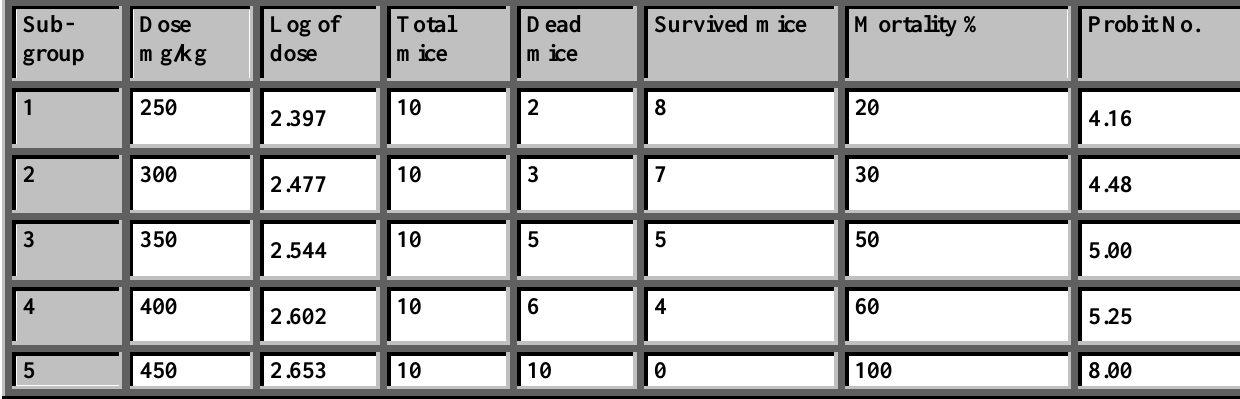
Table 4:- Acute toxicity effect of different doses of hexane extract of WFG of N.oleander leaves in